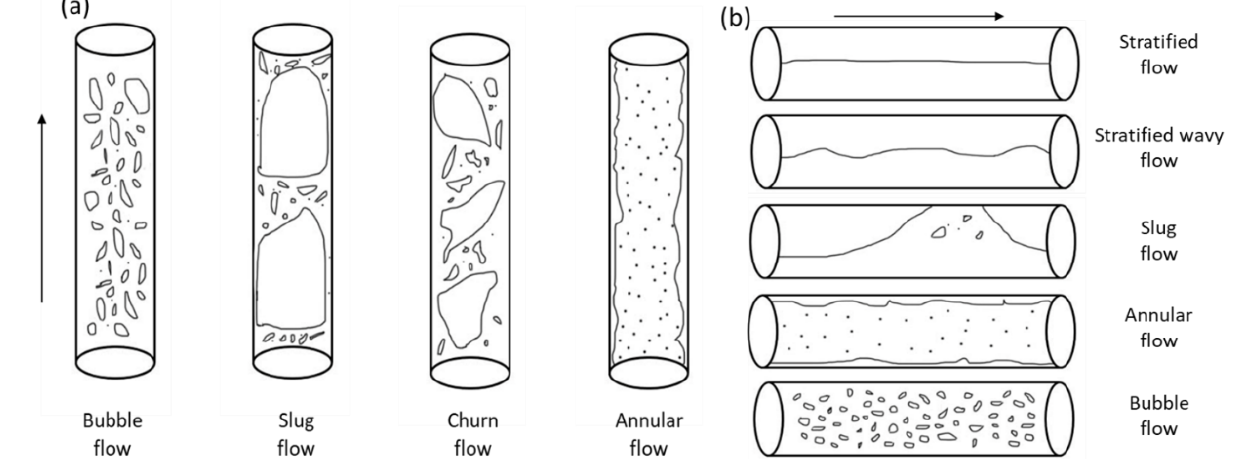
Figure 4. Flow visualization. ( a ) Flow patterns in horizontal pipe, ( b ) flow patterns in vertical pipe. Flow regime is a critical parameter when discussing FIV in two-phase flow and different flow regimes cause different magnitudes of vibrations. Cargnelutti et al.